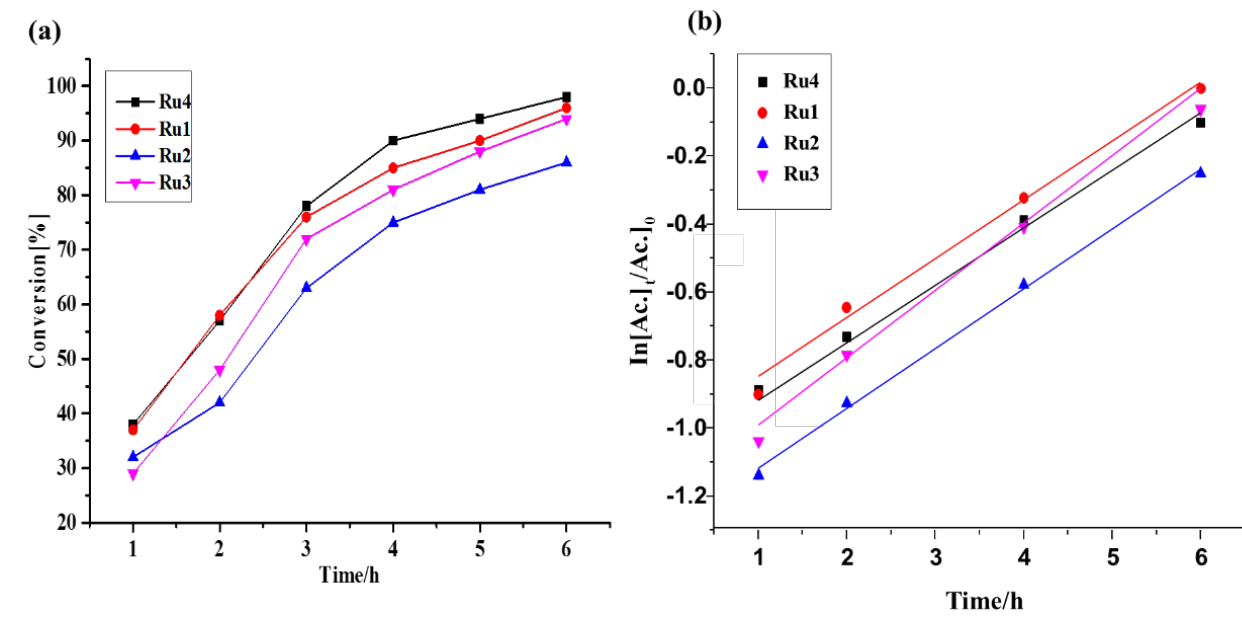
Figure 3. Time-dependent transfer hydrogenation reaction of acetophenone catalysed by Ru1-Ru4 , 5.00 × 10 −3 mol% (50 ppm); t BuOK: 4.0 mol%; temp. 82 °C). ( a ) Yield (%) vs. time graph, ( b ) − In[Ac.] t /[Ac.] 0 vs. time plot of the Ru1-Ru4 catalysts (Ac. — acetophenone). Table 3. Transfer hydrogenation of acetophenone catalysed by Ru1 - Ru4 complexes: Effect of cata- lyst structure a .